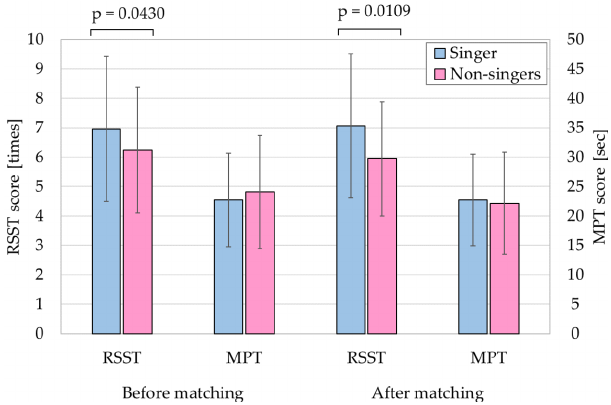
Figure 2. RSST and MPT scores before and after matching. Table 4. Univariate analysis of RSST